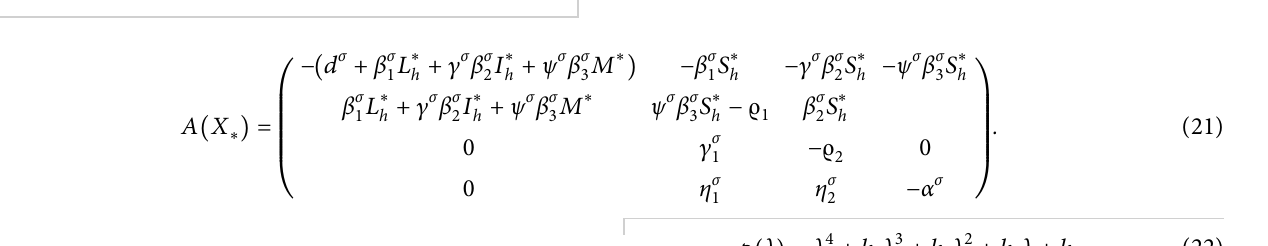
� 0 . 09960, 3 � 1 . 3184, and 2